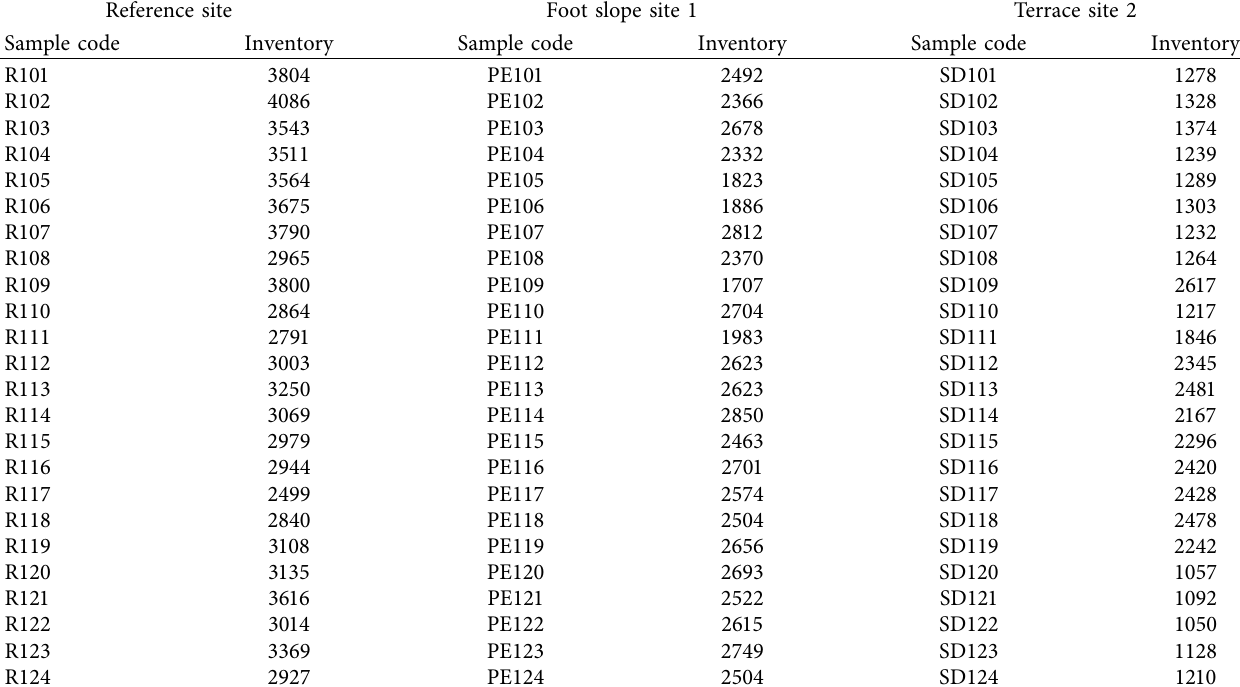
Table 3: Inventories (B/m 2 ) associated with all points collected at reference and study sites.